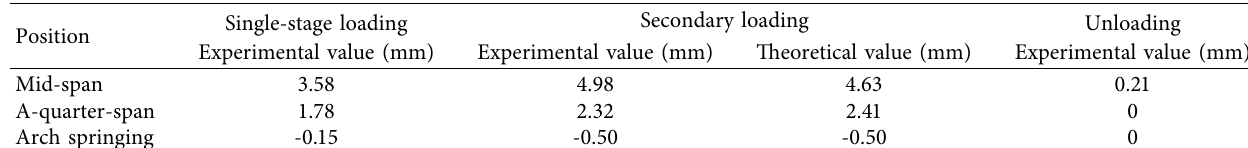
Table 2: Theory and experimental displacement